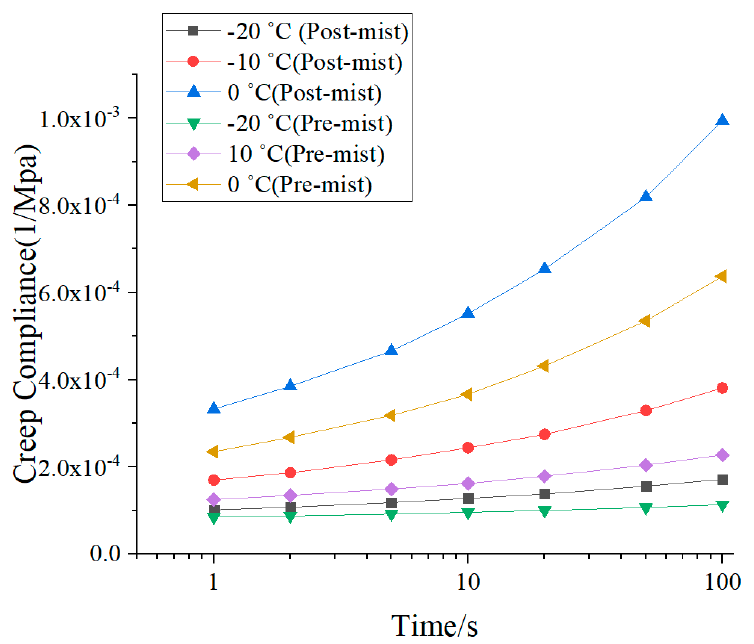
Figure 11. Creep compliance results of pre-mist and post-mist CIR asphalt mixture.